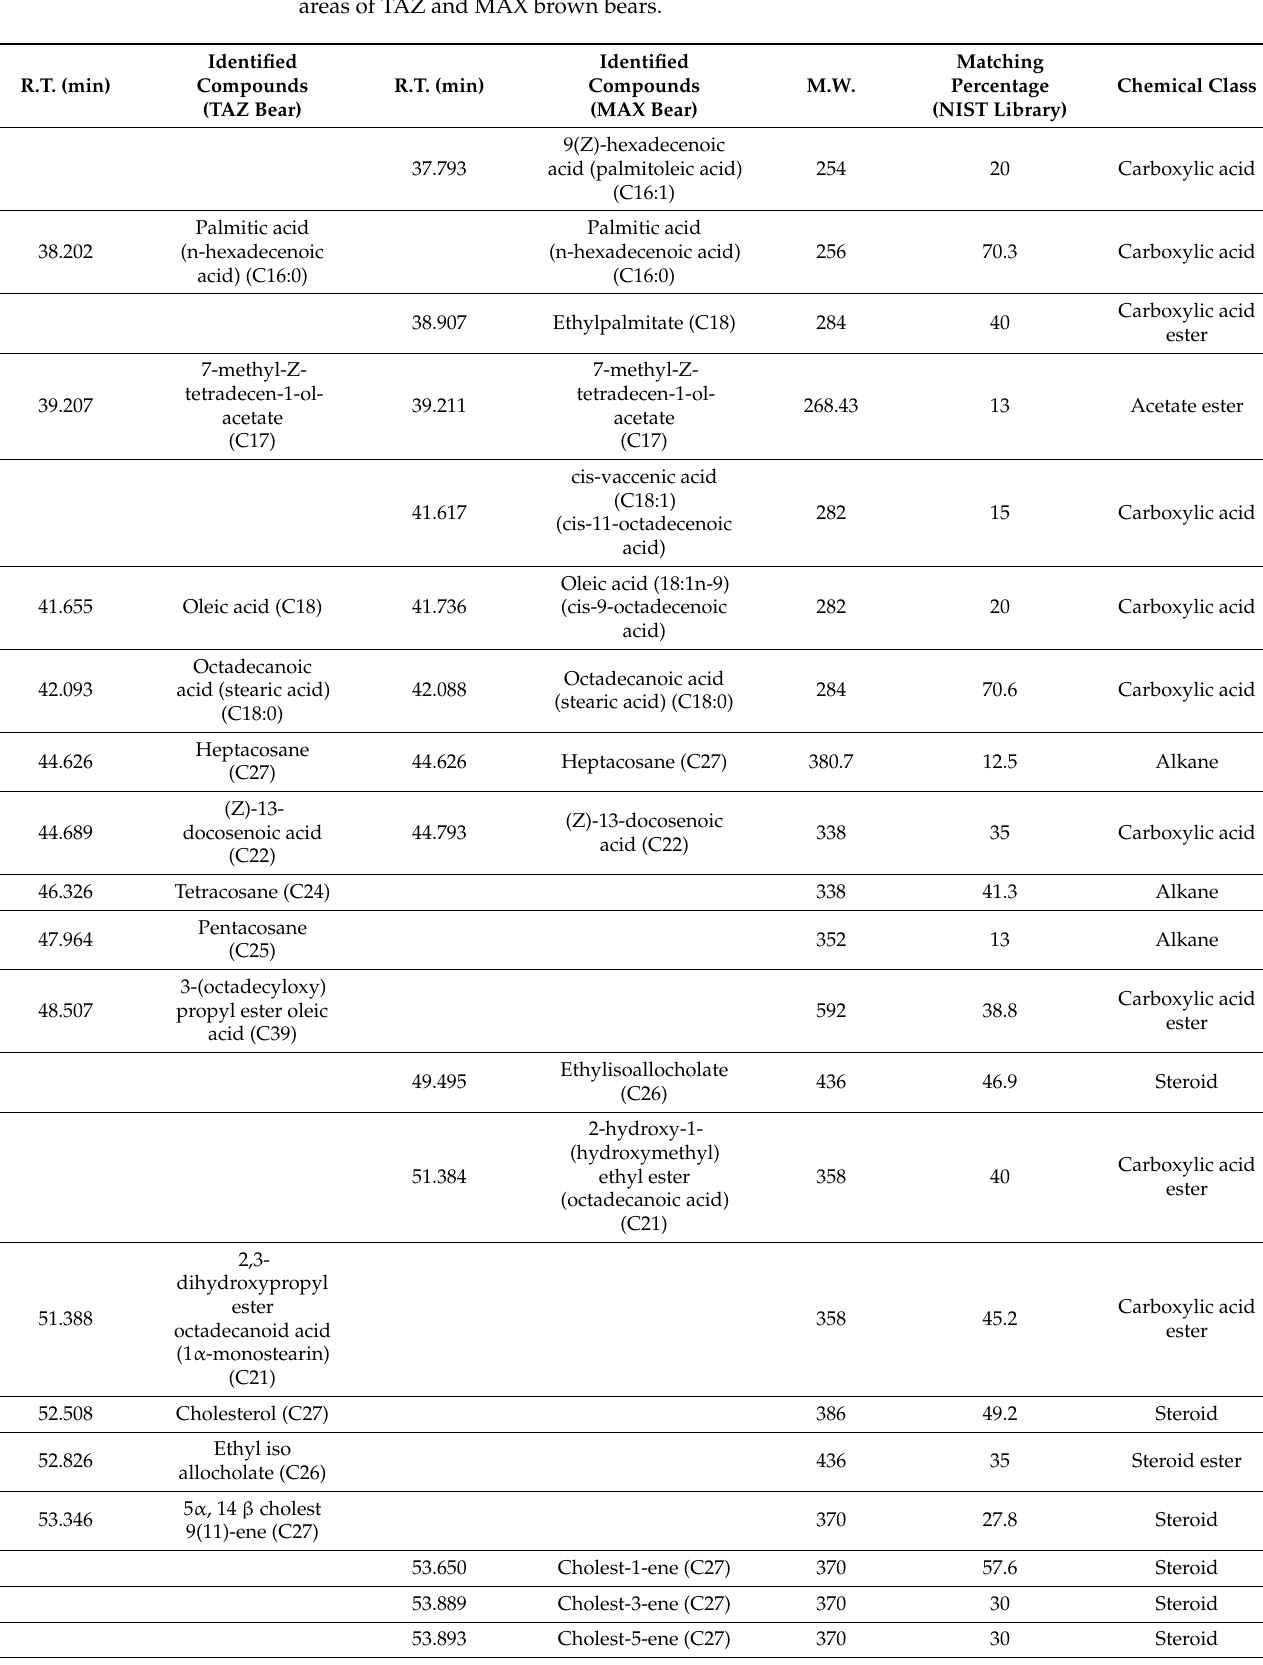
Table 1. List of individual compounds identified in all samples collected from the different body areas of TAZ and MAX brown